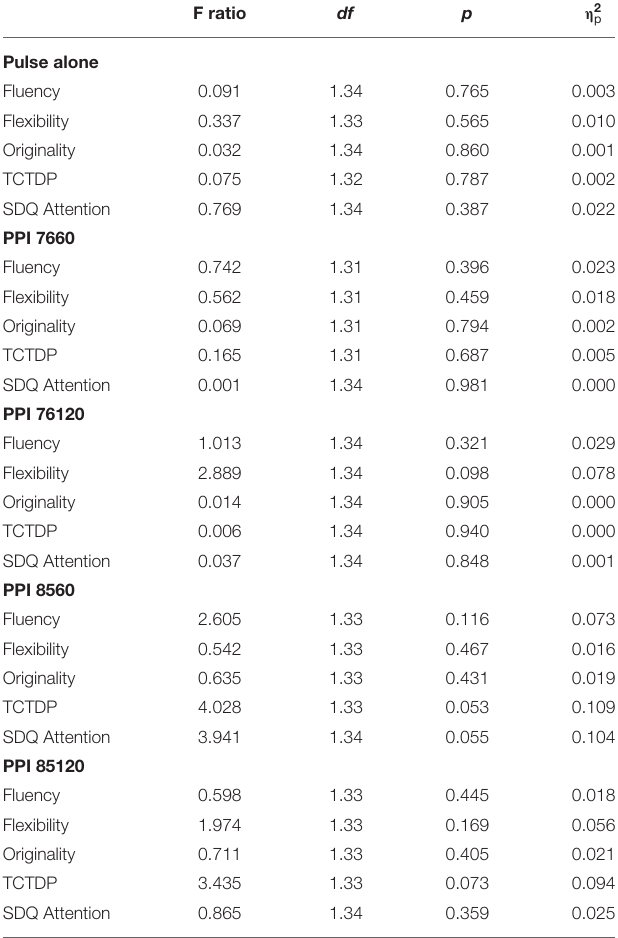
TABLE 4 | ANCOVA statistics for PPI parameters, creativity and SDQ attention